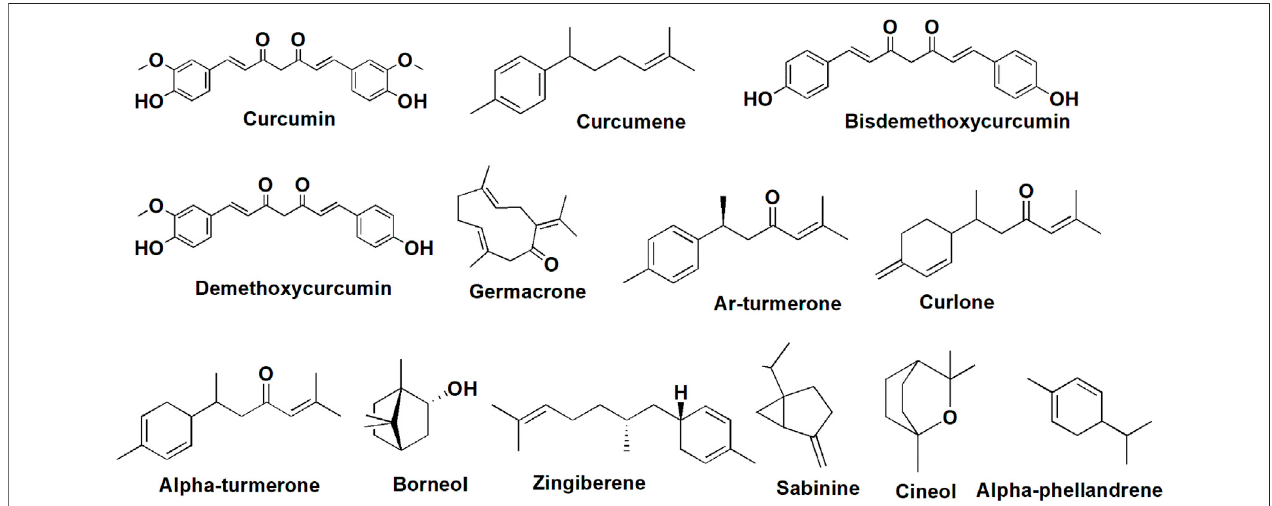
FIGURE 4 | Chemical structure of phytoconstituents present in C.